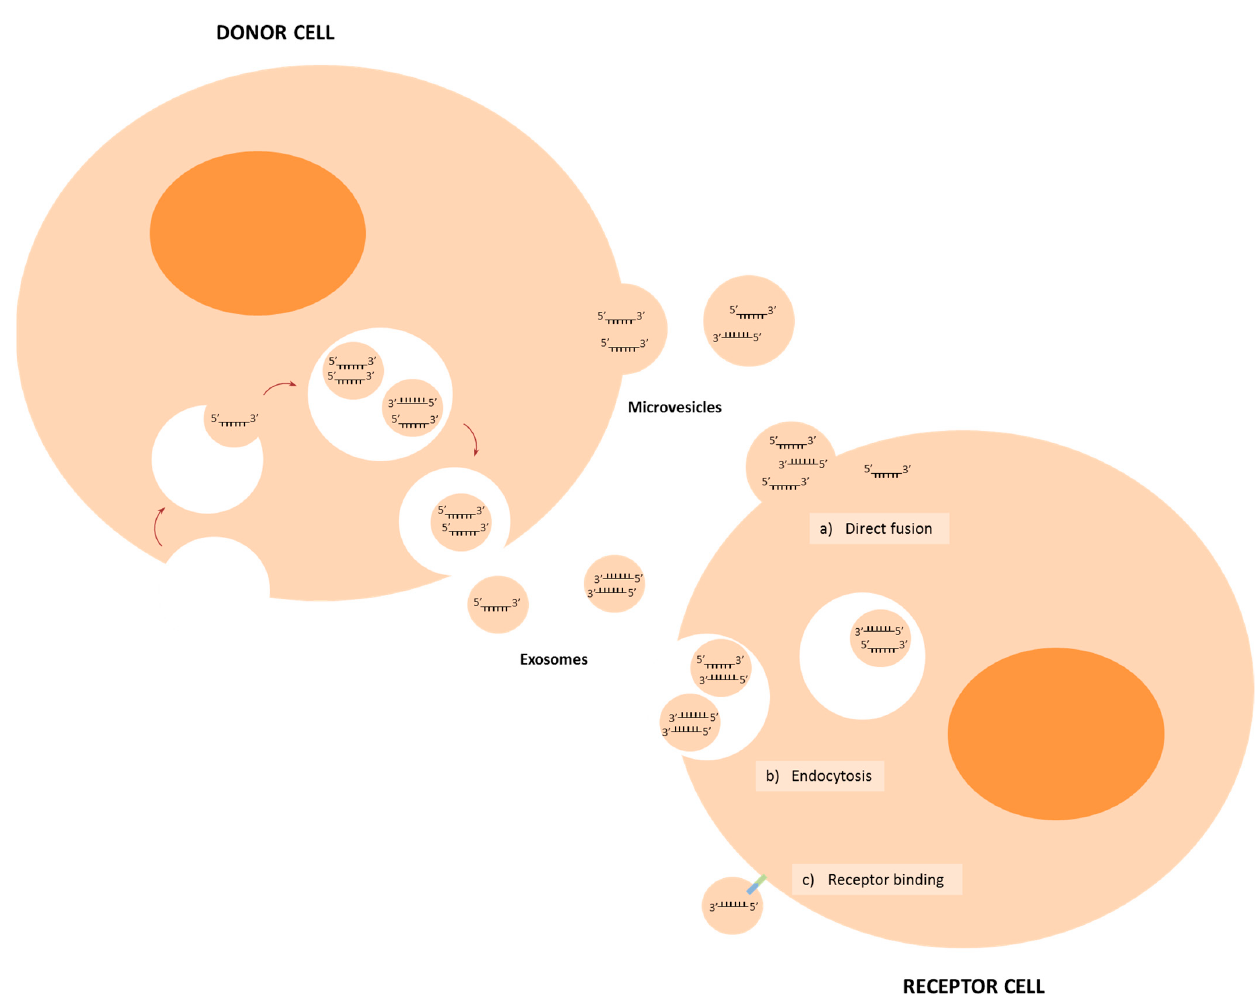
Figure 2. Cross-talk pathways between cells in the tumour microenvironment. It has been described that donor cells secrete miRNAs mainly inside exosomes and microvesicles; these could reach and enter the receptor cell through three different mechanisms: direct fusion, endocytosis and receptor binding. In the recipient cells, these miRNAs perform their function in the case of cancer favouring tumour growth and/or metastasis.